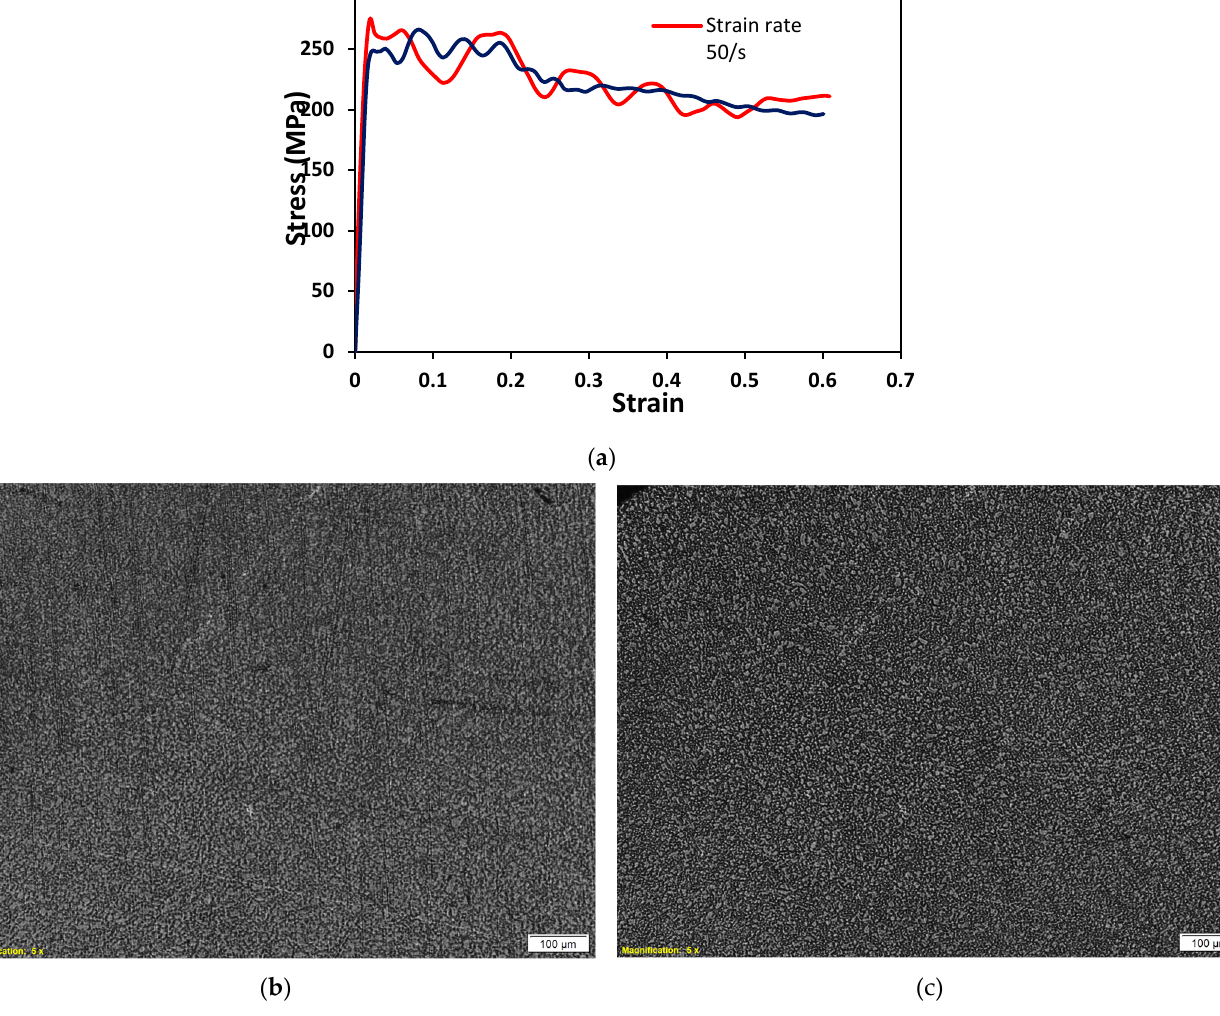
Figure 5. ( a ) The uncorrected flow stress of commercial Ti-6Al-4V obtained from the Gleeble 3500 uniaxial compression experiment and corresponding optical images at ( b ) 20/s; and ( c ) 50/s strain rates. Table 3. Peak flow stress obtained under DEFORM-3D simulation and the Gleeble experiment for Ti-6Al-4V.